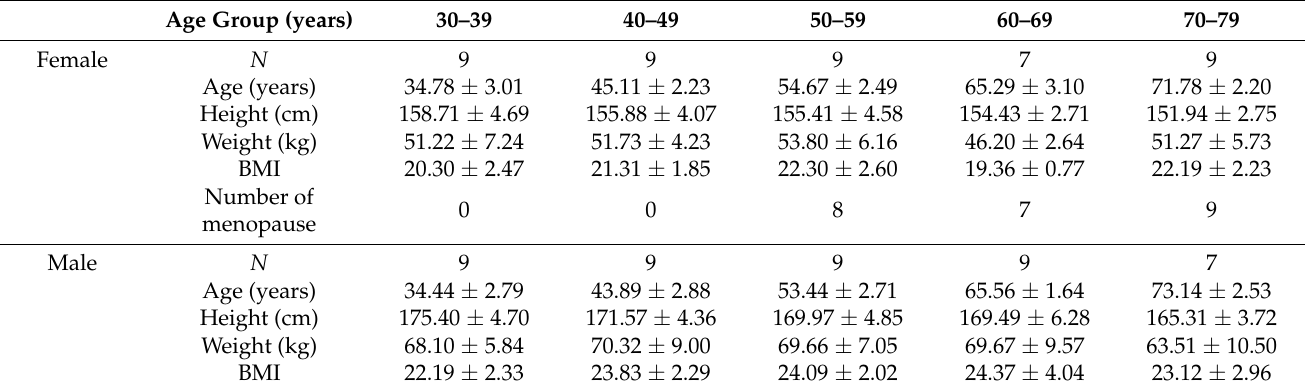
Table 1. Characteristics of the participants.